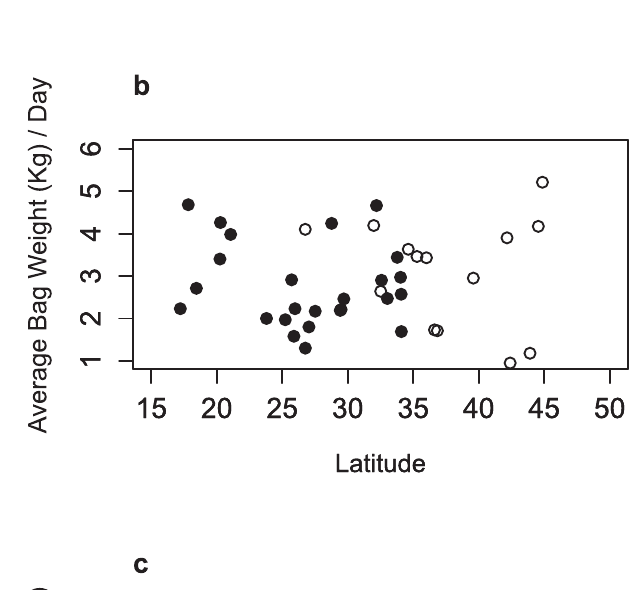
Fig 2. Relative success of alien-invasive and native populations of black bass. Average number of fish retained per angler per day (a), the average daily bag weight of retained fish (b), and the average weight of a fish retained in black bass ( Micropterus spp.) tournaments held in the United States (white dots) and southern Africa (black dots) (c).